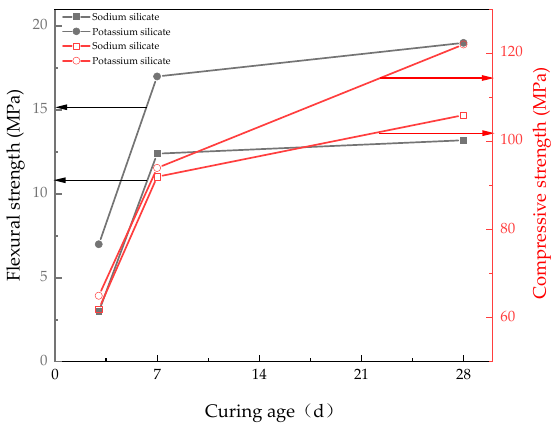
Figure 4. The mechanical strengths of alkali-activated BFS with different alkali activators.